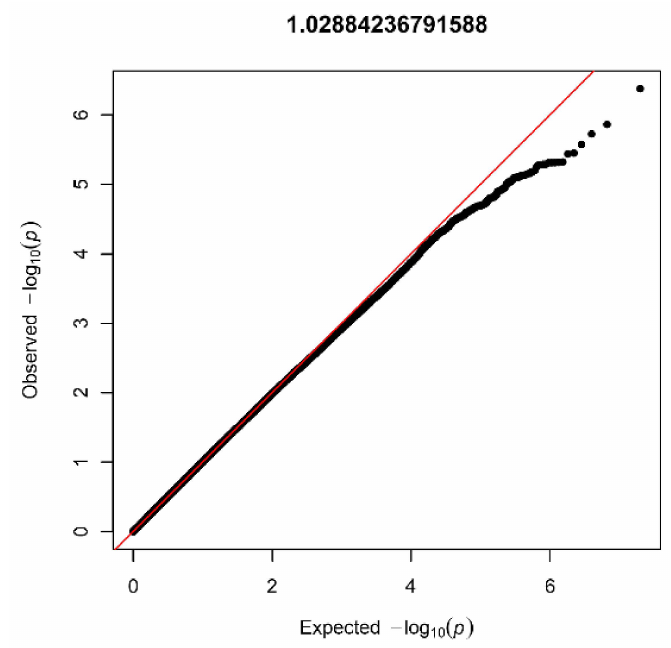
Figure 2. Quantile-quantile plot with lambda value for the AGORA dataset (403 patients and 622